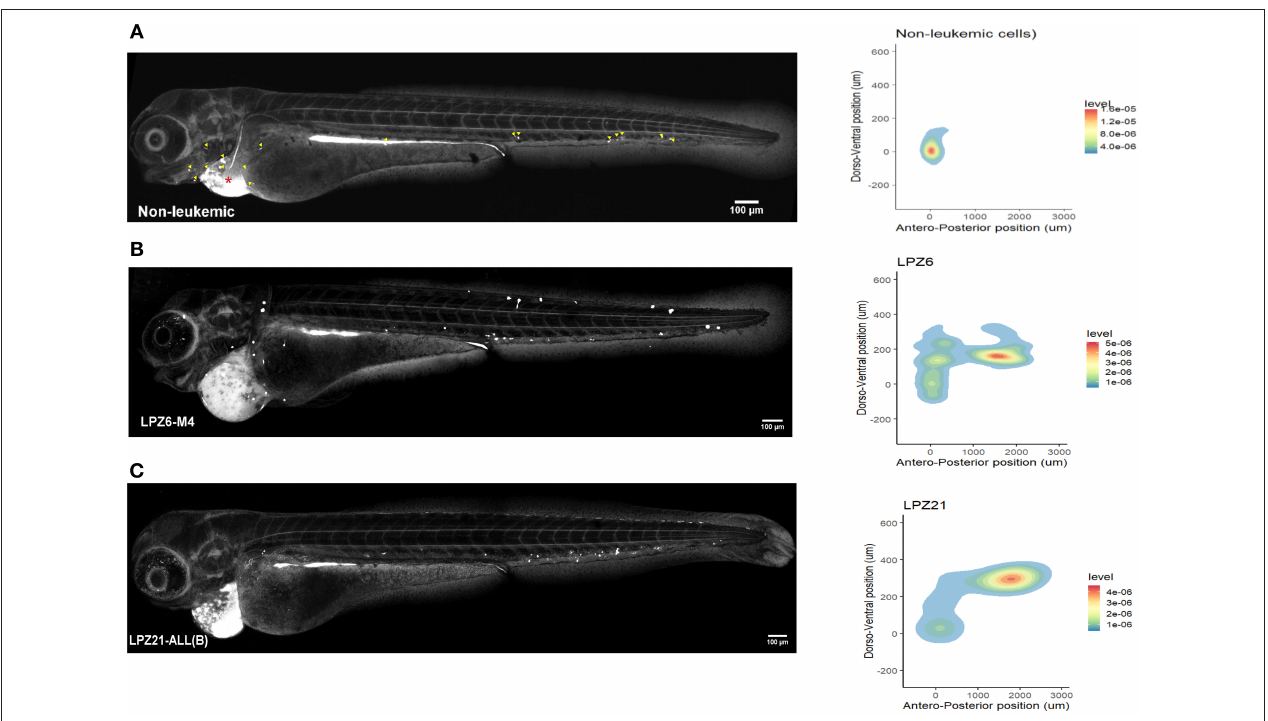
FIGURE 2 | Spatial dispersion pattern of xenografted human cells along zebrafish embryos. The migration of human cells into the zebrafish embryos showed a remarkable heterogeneity and cancer cells presented higher dissemination patterns. (A–C) Confocal reconstructions of zebrafish embryos at 1 dpi and spatial dispersion pattern of xenografted human cells. (A) Non-leukemic cells. Yellow arrowheads correspond to fluorescent foci as a guidance to recognize them in leukemic xenografted embryos. Red asterisk represents the site of injection. (B) LPZ6-M4 (C) LPZ21 (B-ALL) sample. Cells were labeled with CFSE and engrafted in the pericardial space of zebrafish embryos at 48 hpf. A fluorescent signal, dorsal to the yolk, was detected at the digestive system in all xenografted embryos due to the metabolism of CFSE ( n = 6 embryos per cell